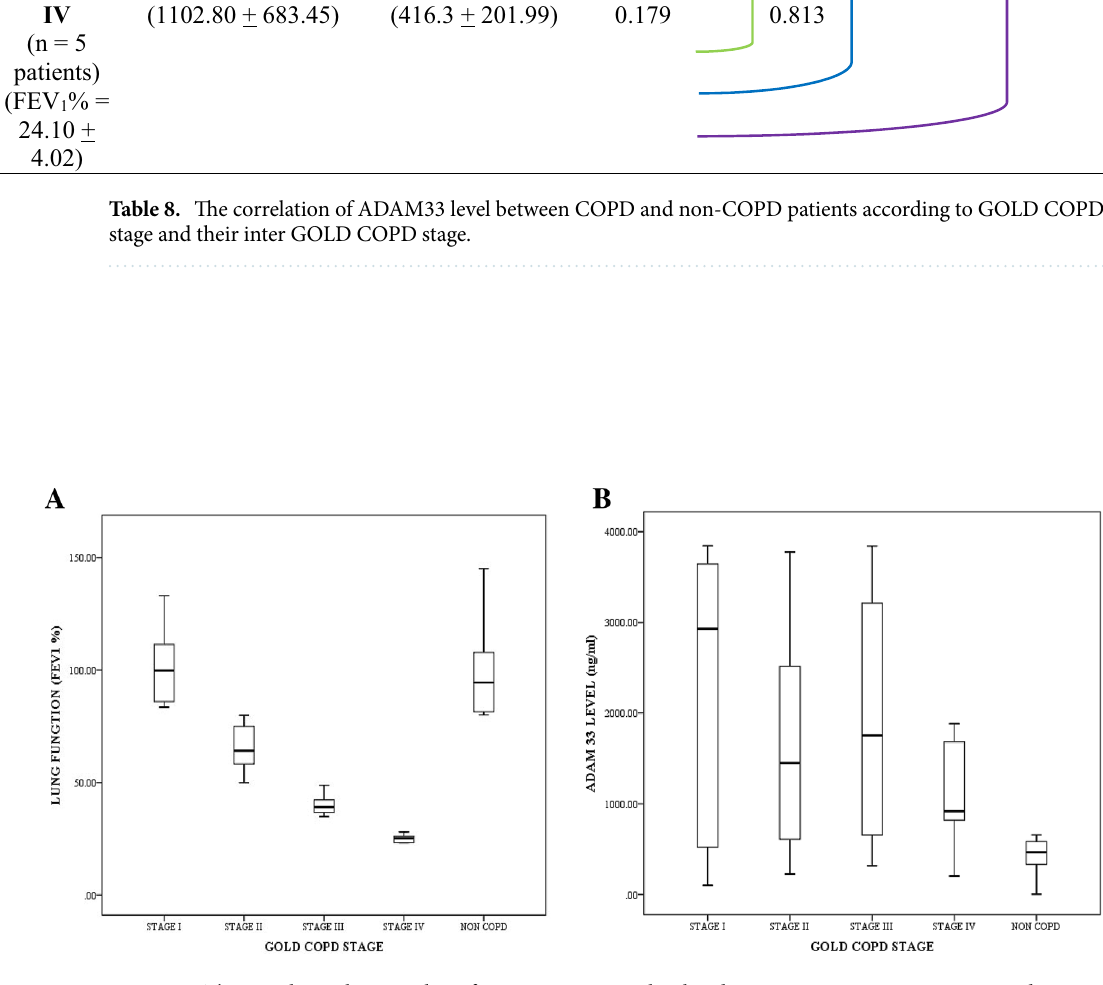
Figure 8. The correlation between lung function, ADAM33 level and GOLD COPD stage in COPD and non-COPD patients; ( A ) the lung function and GOLD COPD stage in COPD and non-COPD patient; ( B ) the ADAM33 level and GOLD COPD stage in COPD and non-COPD